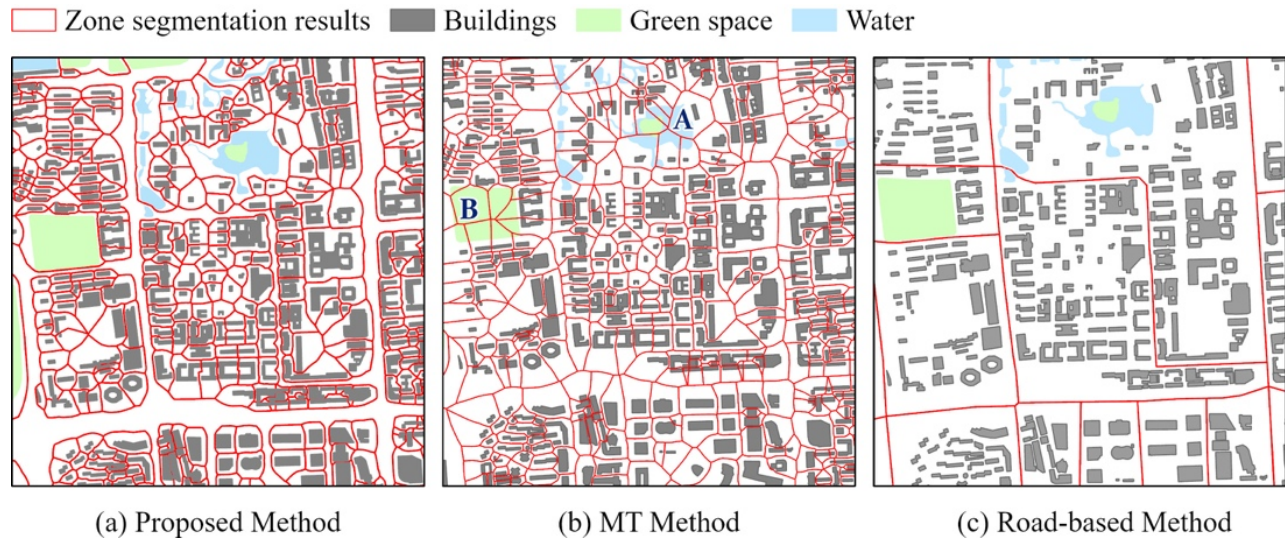
Figure 9. Zone segmentation results. ( a ) Proposed method. ( b ) MT method. ( c ) Road-based method.